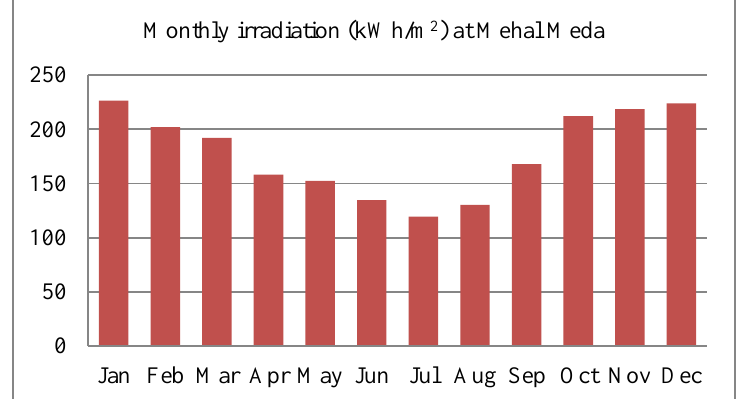
Figure 16. Solar radiation assessment of North Shewa zone at Mehal Meda.